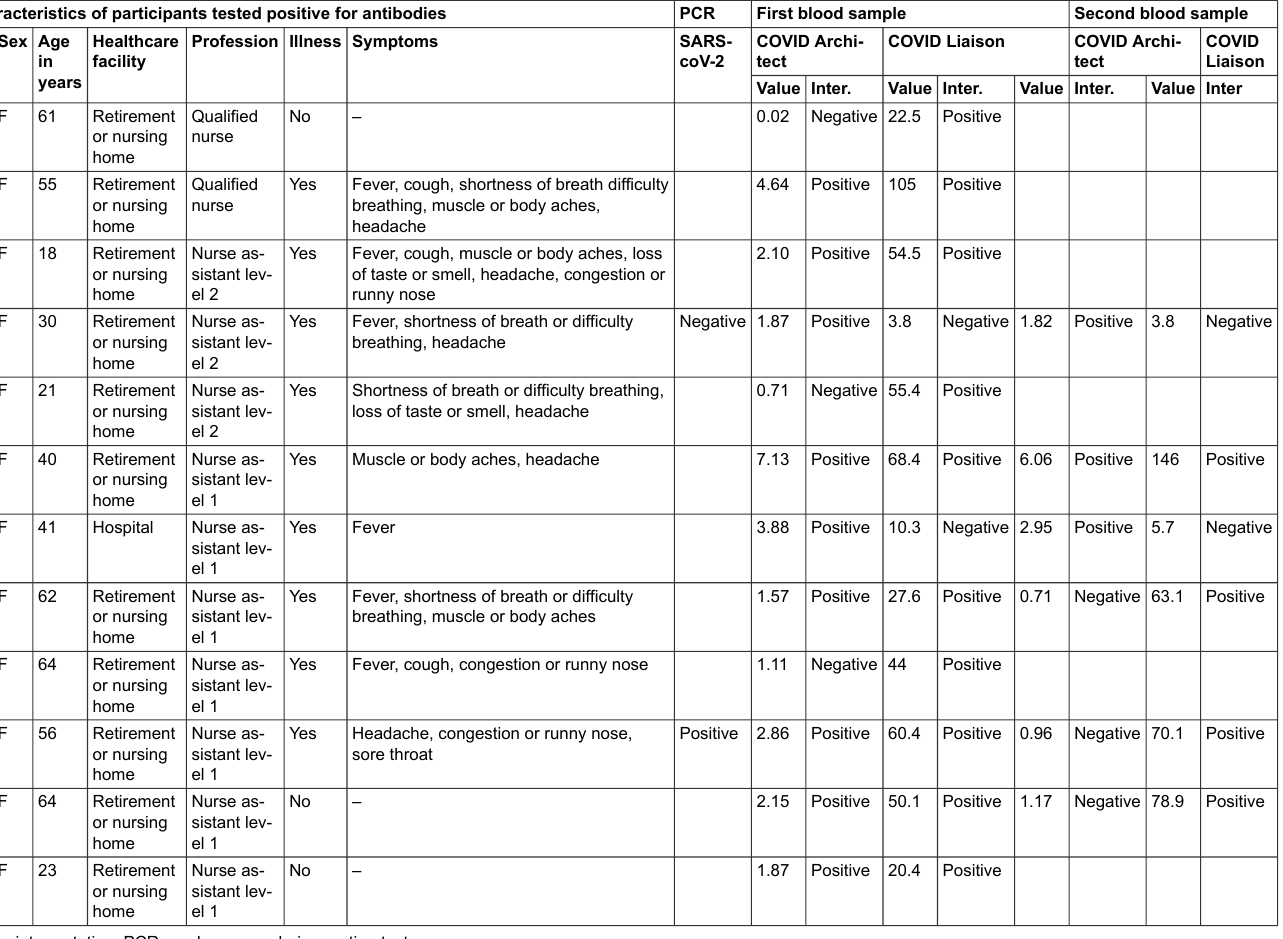
Inter. = interpretation; PCR = polymerase chain-reaction